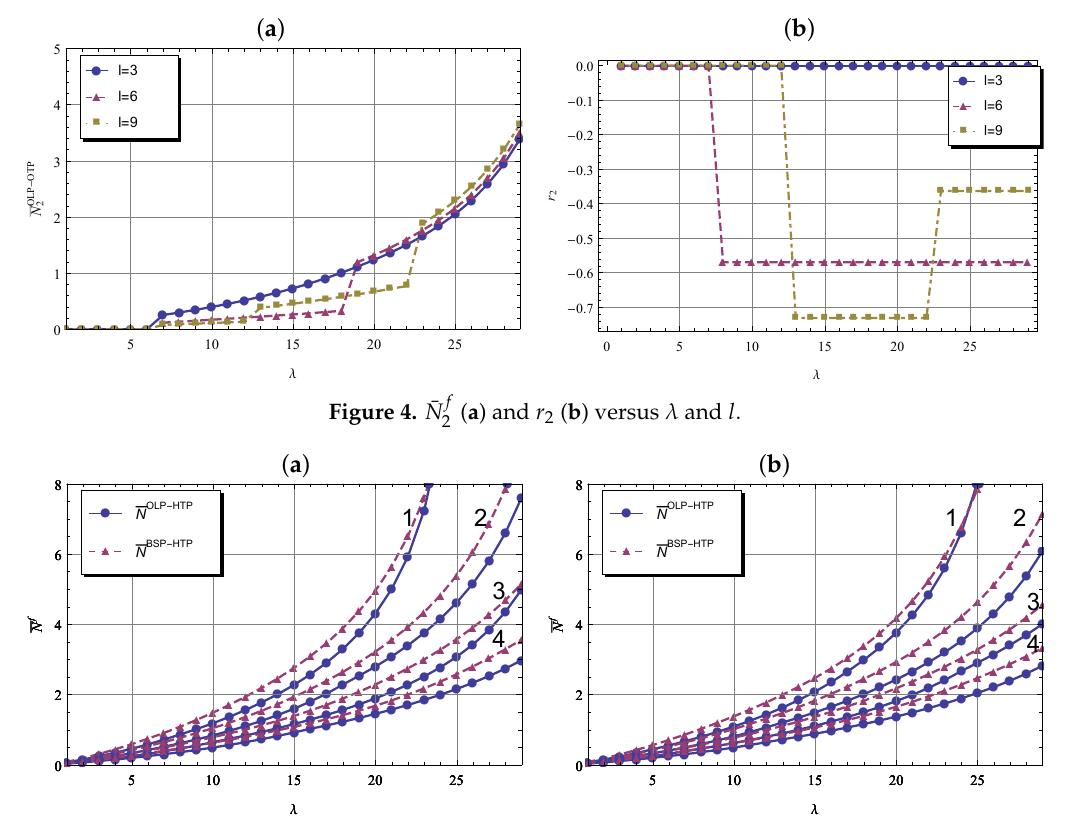
Figure 5. Functions ¯ N f for µ 12 = 10, µ 22 = 2 ( a ) and for µ 12 = 12, µ 22 = 2.4 ( b ) versus λ , µ 11 and µ 21